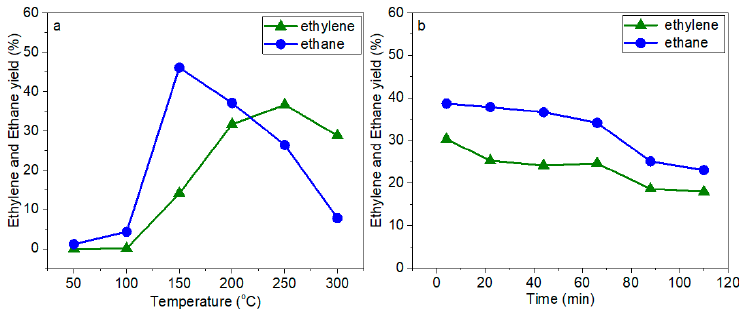
Figure 11. Catalytic HDCl of TCE on ZrO 2 supported spherical (s) Pd NPs: ( a ) ethylene and ethane yield vs. temperature; and ( b ) ethylene and ethane yield vs. time at 200 °C.